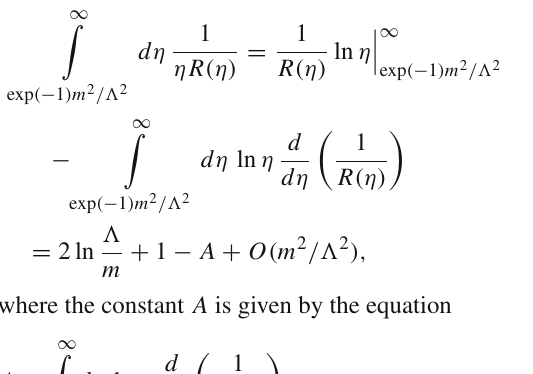
of the remaining